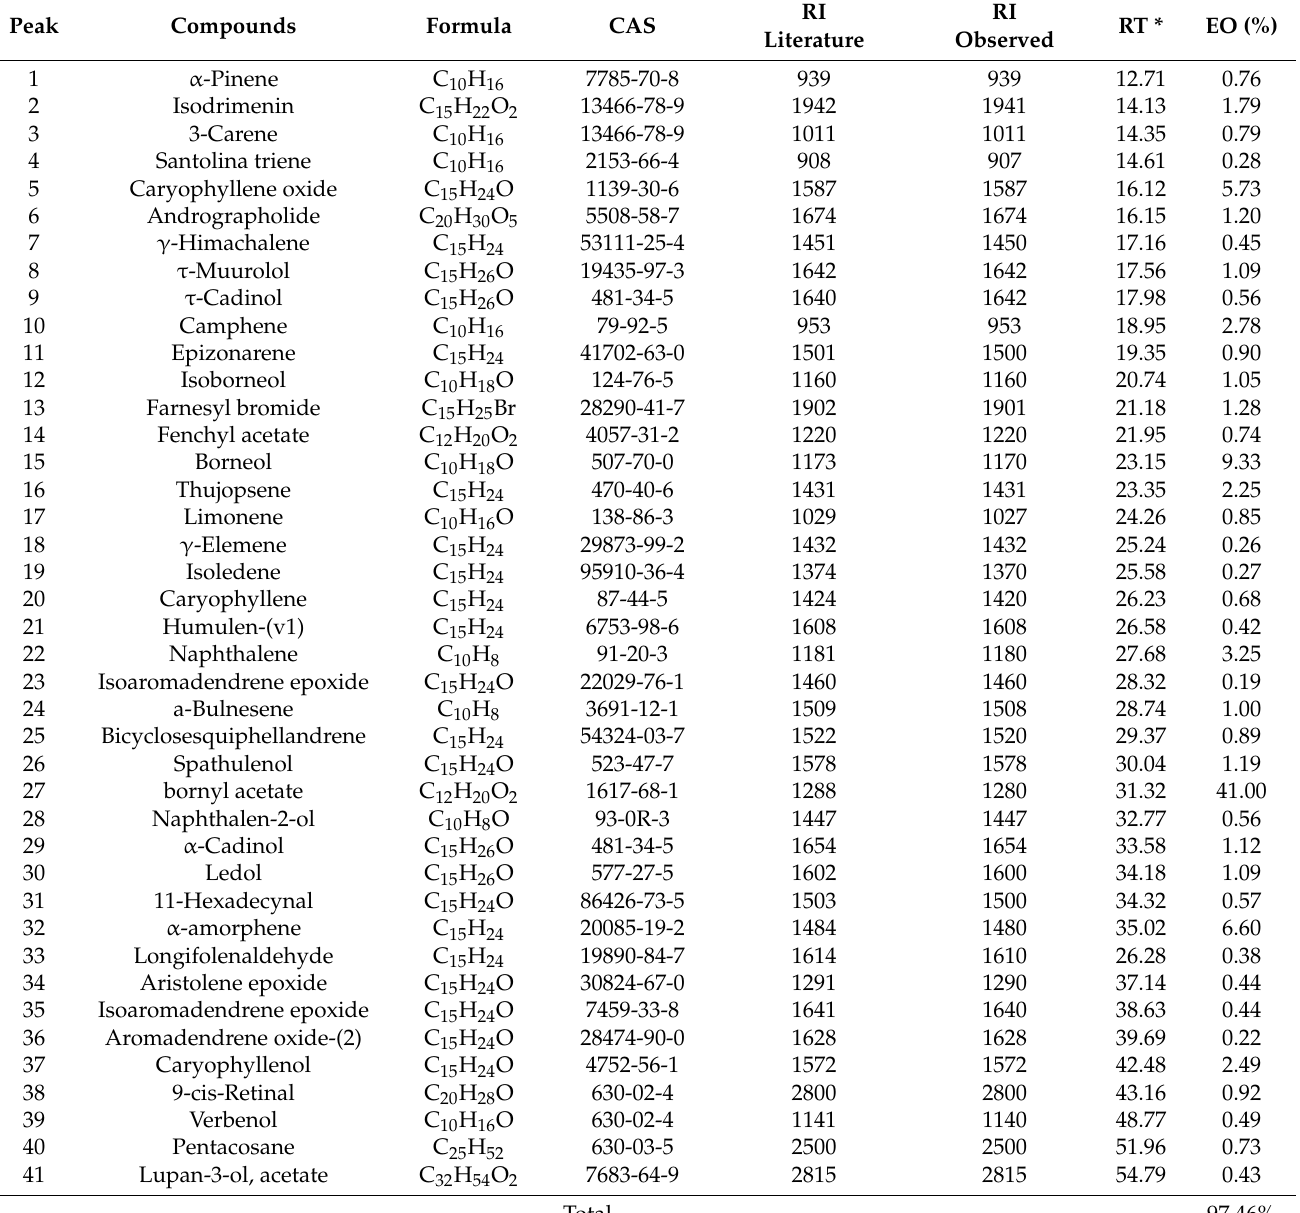
Table 1. Chemical composition of the essential oil extracted from leaves of D. viscosa